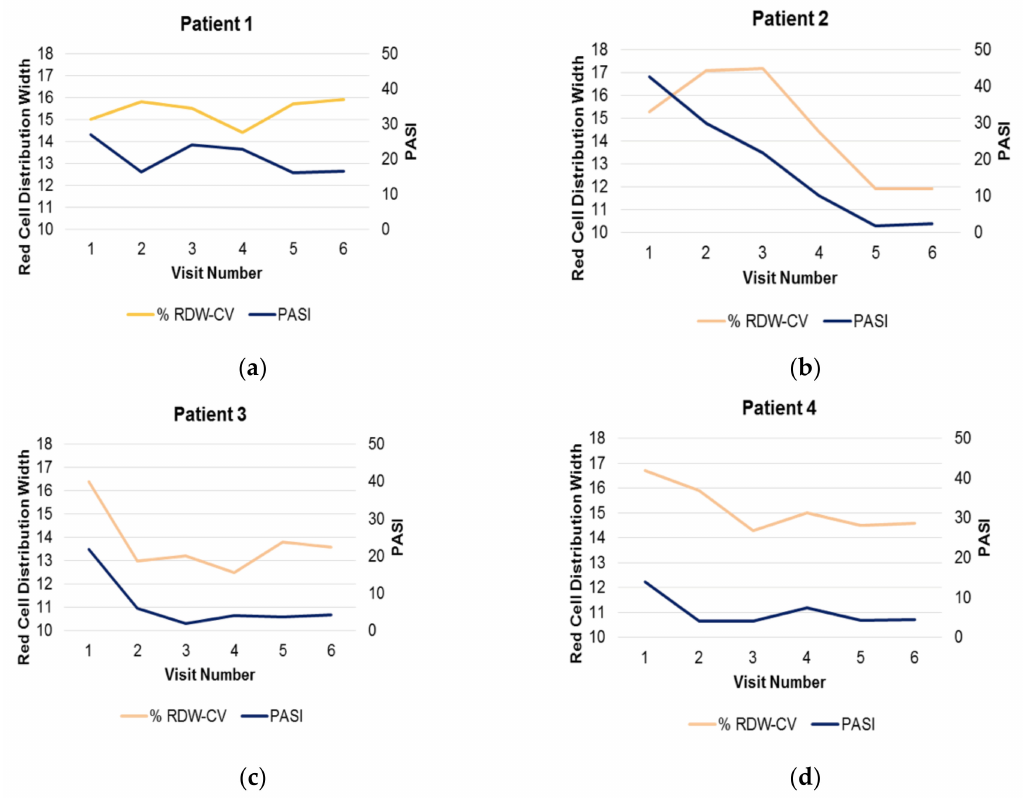
Figure 4. Alteration in red cell distribution (RDW) and psoriasis area and severity index (PASI) following therapeutic treatments. Change in RDW and PASI are indicated on the left and right axes, respectively. Patients were treated for the indicated time with several independent systemic therapies including acitretin and phototherapy ( a ), methotrexate followed by adalimumab ( b ), infliximab and methotrexate ( c ) and an additional methotrexate followed by adalimumab ( d